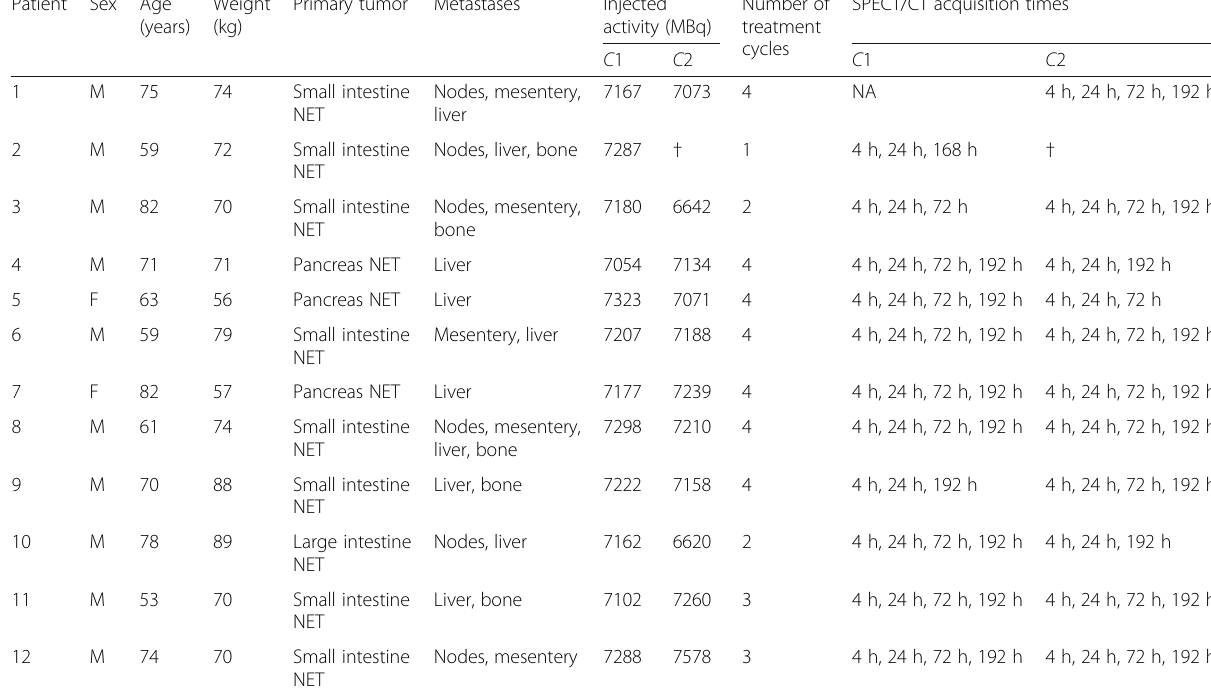
Table 1 Patients ’ characteristics Patient Sex Age Weight (years)